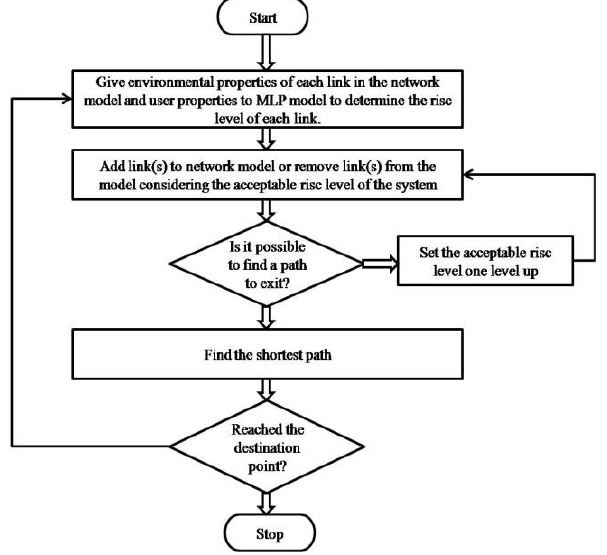
Figure 7. Evacuation process.